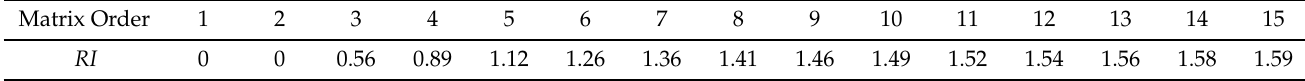
Table 4. Stochastic consistency index RI